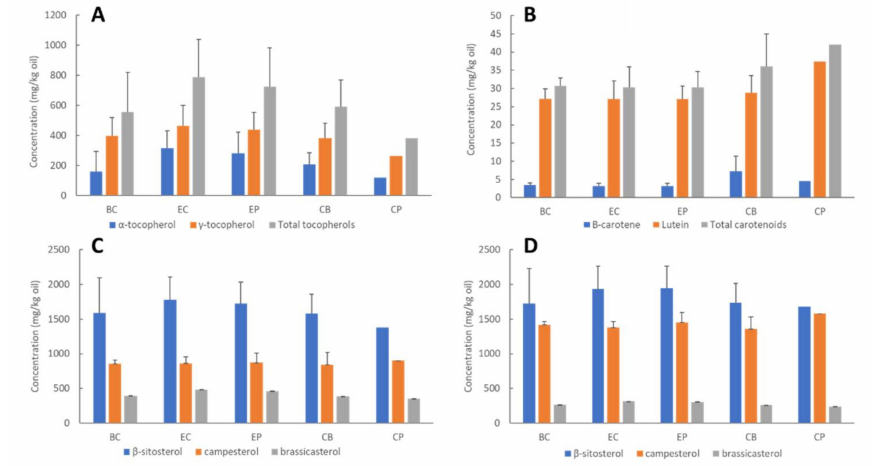
Figure 2. Concentrations of tocopherols: ( A ) carotenoids; ( B ) free sterols; ( C ) esterified sterols; ( D ) in canola seeds from each process. Each bar represents the average of batches one and two (Total n = 4), error bars represent standard deviation between the batches. Note: Only a single batch was acquired (i.e., n = 2) for process CP; Free + esterified = total